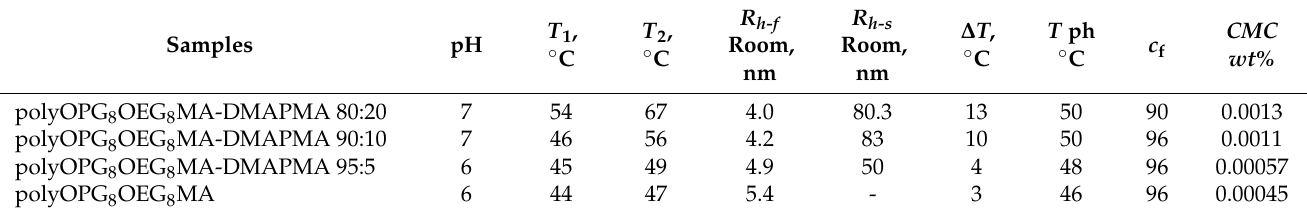
Table 3. Characteristics of solutions of polyOPG 8 OEG 8 MA-DMAPMA at c = 0.005 g · cm − 3 in